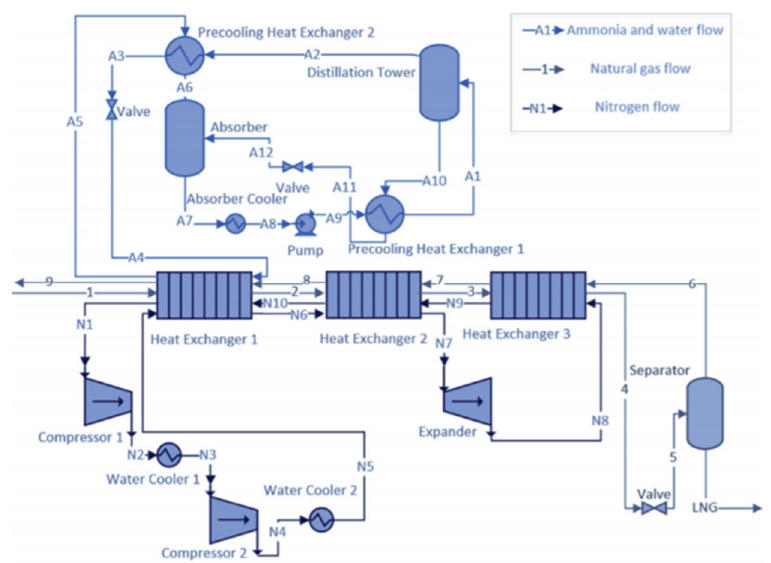
Figure 22. Single nitrogen expansion process with ammonia absorption pre-cooling [69]. Reproduced with permission from